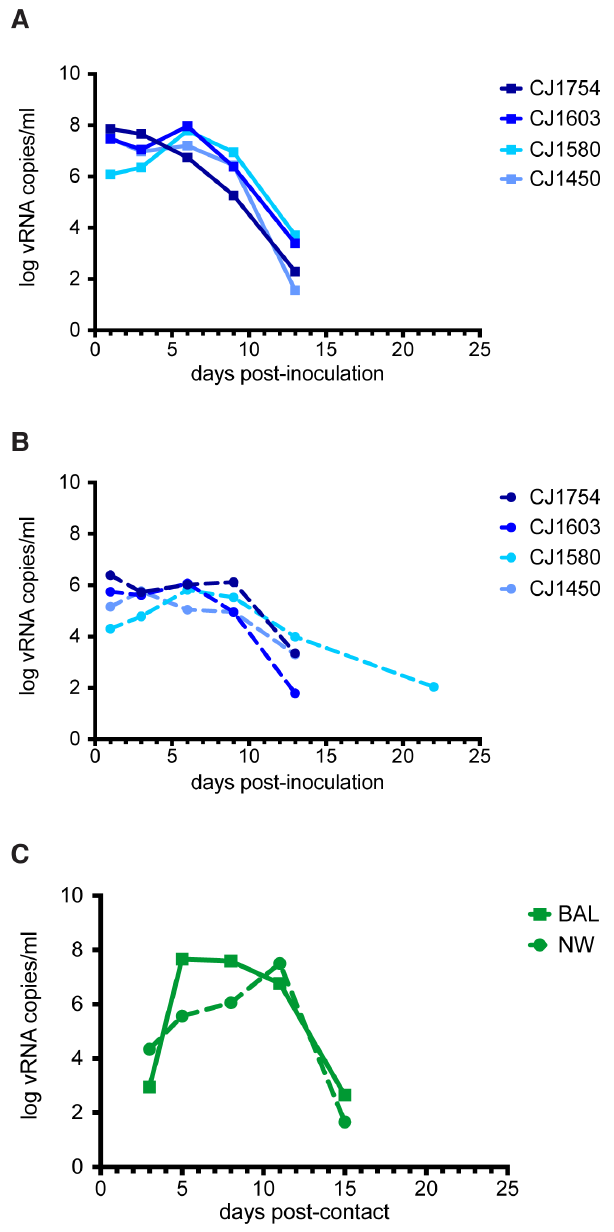
Figure 1. The human influenza virus isolate A/California/07/ 2009 replicates to high titers in common marmosets. Log vRNA copy number was determined by QRT-PCR in (A) the lower respiratory tract using bronchoalveolar lavage (BAL) and (B) in the upper respiratory tract using nasal washes (NW). (C) Viral RNA was also detected in the lower (solid traces) and upper (dashed traces) respiratory tracts of one contact animal, CJ1721.